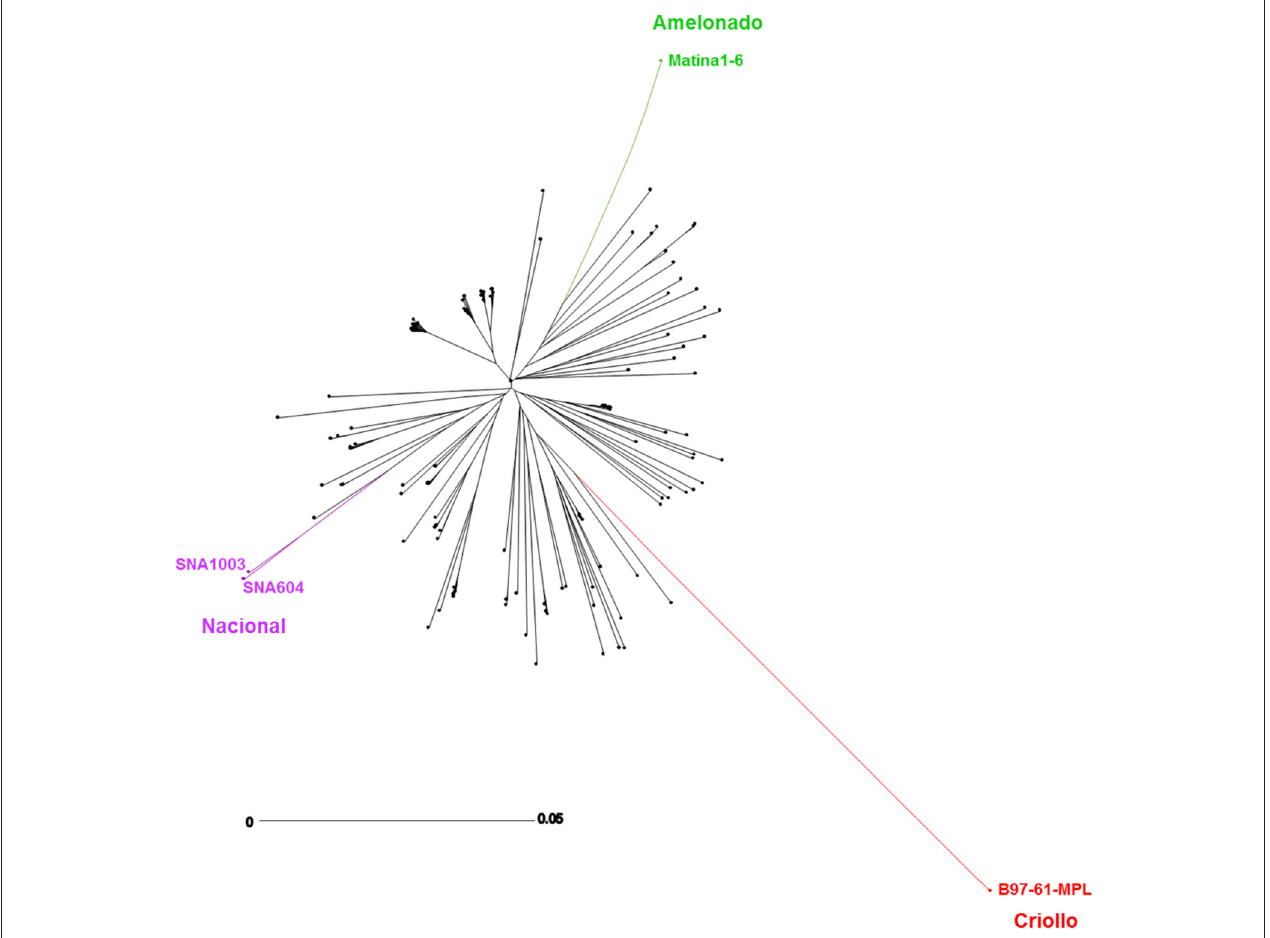
FIGURE 1 | Phylogenetic tree representing the modern Nacional population and its ancestors. Phylogenetic tree of the individuals of the studied population made with 4,130 SNPs and including the ancestor controls of the population: in red, the Criollo variety (B97-61-B2); in purple, the Nacional variety (SNA604, SNA1003); in green, the Amelonado variety (Matina 1–6); in black, the individuals of the studied population. The graph’s scale represents the edge lengths which are proportional to the genetic